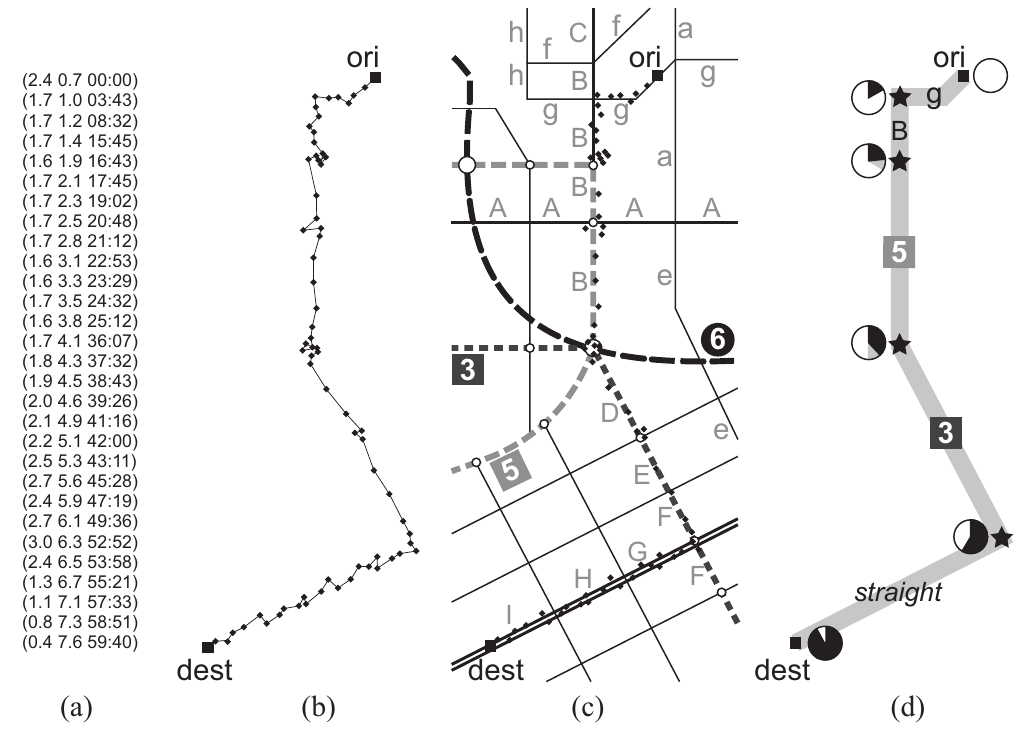
Figure 1: Problem overview (adapted from [39]). (a) Raw positional data as fi xes ( x,y,t tu- ples); (b) trajectory in two-dimensional space, object moving from origin to destination; (c) trajectory embedded in semantic geographic context; (d) compressed representation of the same trajectory with timestamped reference points as indicated by the clock symbols: from origin, to street g , street B , tram line #5, tram line #3, straight , to destination, clock symbols with grey sectors represent